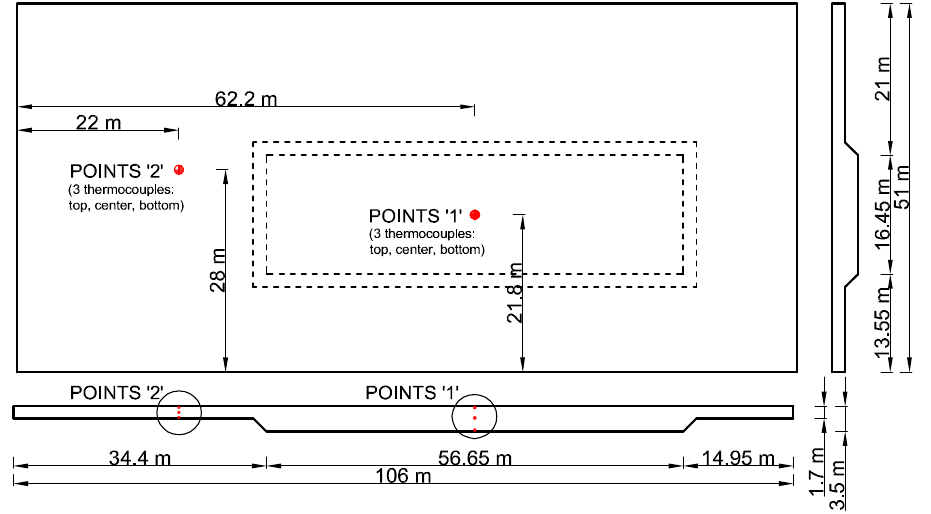
Figure 9. The dimension of the foundation slab with the position of the thermocouples in points ‘1’ and ‘2’.